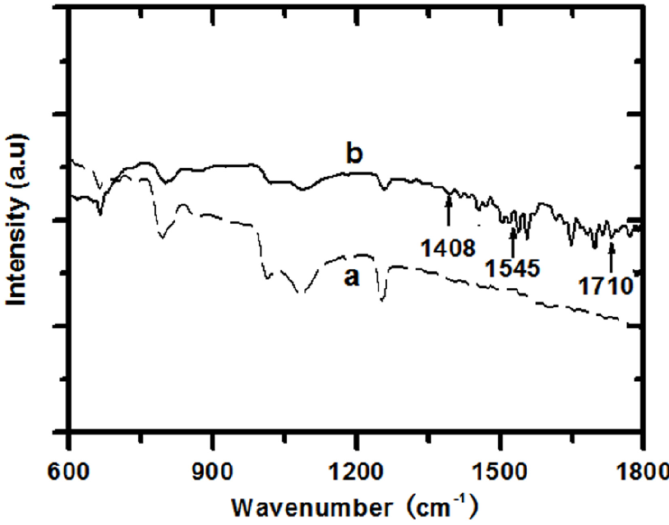
/SWCNT and ( b ) PAA/SnO 2